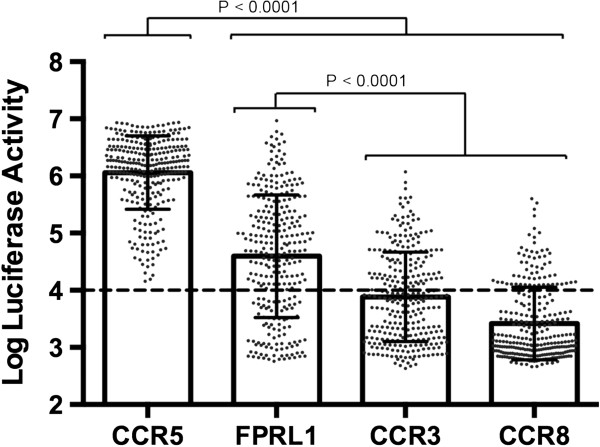
Alternative coreceptor usage by R5 C-HIV Envs. Luciferase reporter viruses pseudotyped with each of the C-HIV R5 Envs (n = 294) were used to infect NP2-CD4 cells expressing CCR5, FPRL1, CCR3 or CCR8, and the levels of HIV-1 entry were determined as described in the Methods. The background level of luciferase activity, as determined by infections with luciferase reporter virus pseudotyped with the non-functional ΔKS Env [44], is shown by the horizontal dashed line. The data shown are the means and standard deviations of entry levels of all the R5 C-HIV Envs in the different cell types, and are representative of 3 independent experiments, each performed in triplicate. The individual dots represent mean entry levels of triplicates from a representative experiment. Statistical comparisons were made using a Mann–Whitney U test. P values < 0.05 were considered statistically significant.